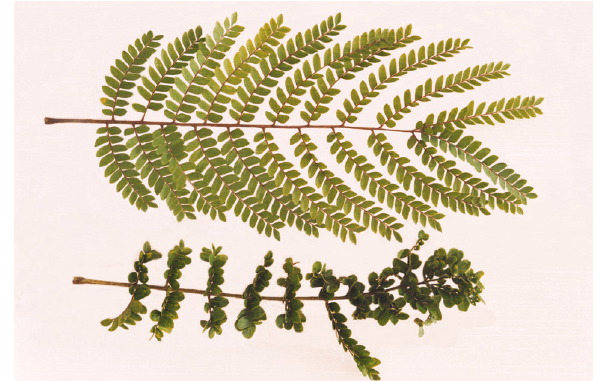
Figura 1 . Adultos de Isogonoceraia divergipennis, mostrando a diversidade de cores apresentada pelo inseto.